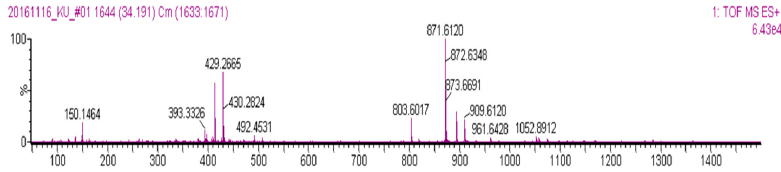
Figure 12. LC/MS analysis of two fractions of the oligomeric anthocyanin.